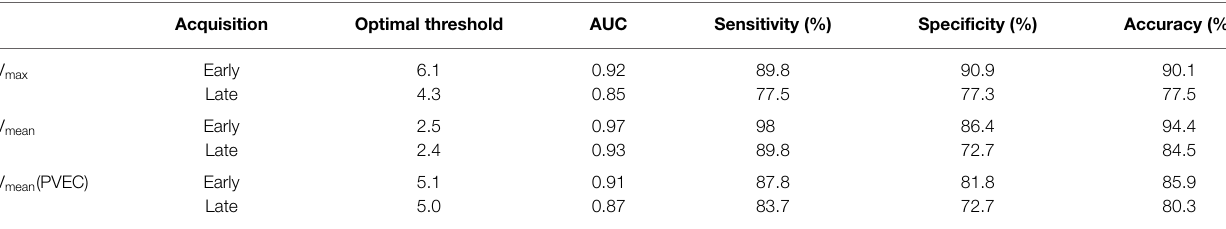
Acquisition Optimal threshold AUC Sensitivity (%) Specificity (%) Accuracy (%) SUV max